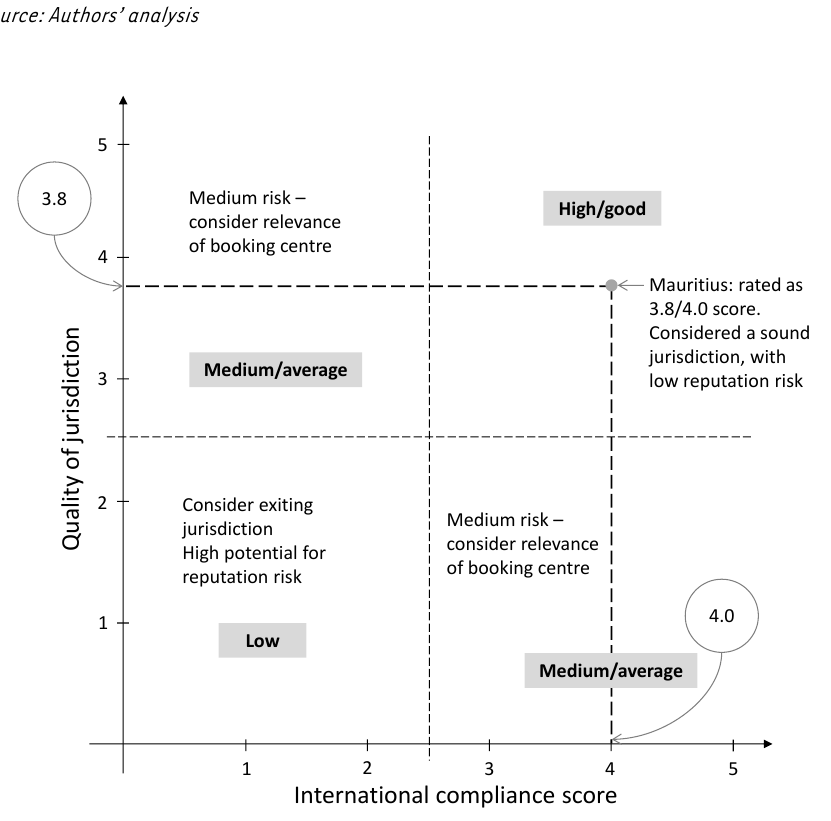
FIGURE 1: External jurisdiction assessment. Source: Authors’